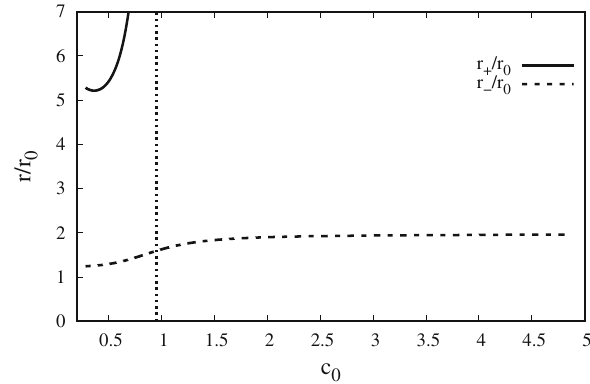
Fig. 1 Real roots of b ( r ) as a function of c 0 . The bigger roots cor- respond to the solid line and the smaller roots to the dashed line. The constant value of 1 (dotted line) corresponds to the case r root = r 0